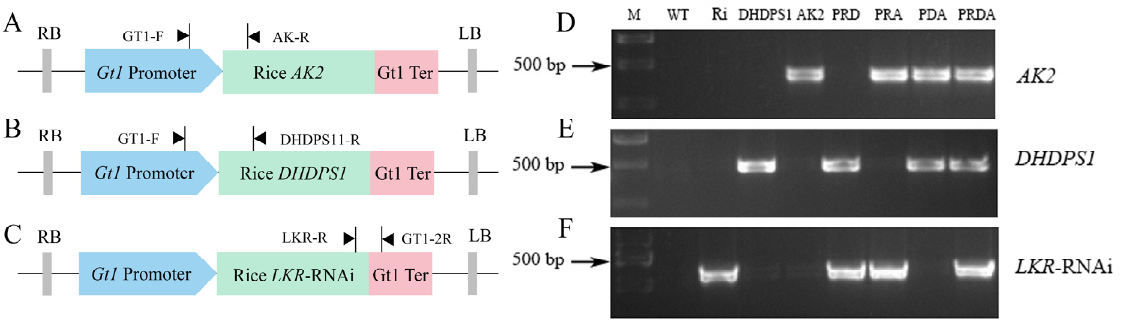
Figure 1. PCR analysis of target genes in the transgenic rice plants. ( A – C ) Construction of the recombinant vector and detection primers. Detection of ( D ) the AK gene, ( E ) the DHDPS gene, and ( F ) LKR -RNAi structure in the transgenic and wild-type (WT)